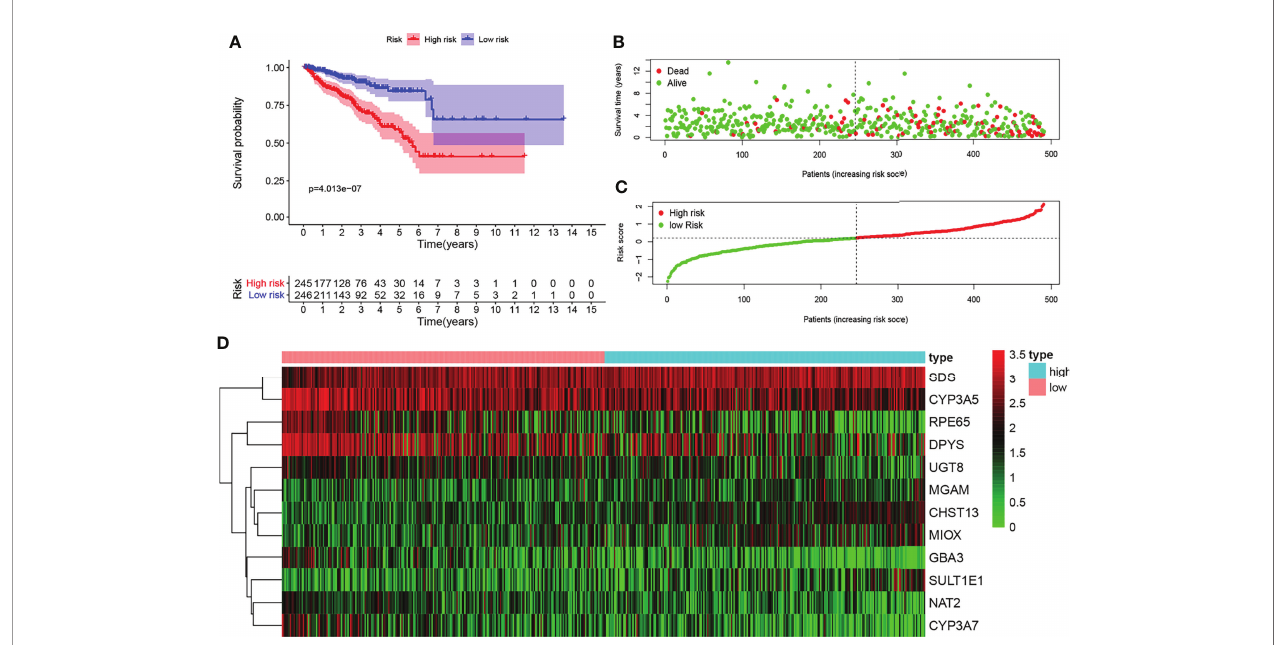
FIGURE 2 | Survival risk assessment of metabolic prediction models (MPMs) consists of a metabolic 12-mRNA signature in The Cancer Genome Atlas (TCGA) and the Clinical Proteomic Tumor Analysis Consortium (CTPAC) cohorts. (A) The 12-mRNA signature model (MPMs) in prostate adenocarcinoma (PRAD) patients was calculated using least absolute shrinkage and selection operator (LASSO) regression analysis. Kaplan – Meier survival analysis showed signi fi cant predictive value of the risk score depending on MPMs in TCGA cohort. (B – D) The distribution of survival time, (B) status, (C) risk score, and (D) hierarchical partitioning of 12 signatures in tumor and normal samples is shown in TCGA